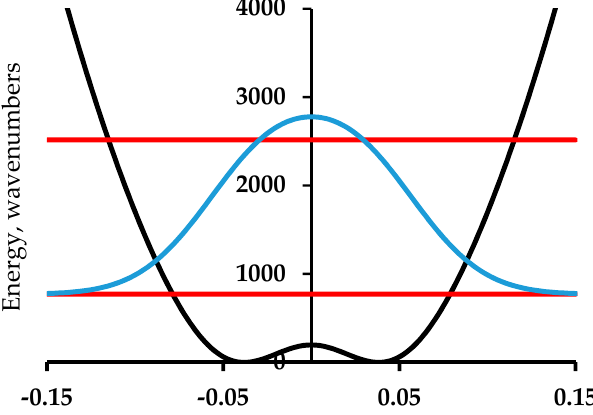
Displacement from symmetry point, Å Figure 5. An analytical model potential energy (black curve) for the Peierls bond alternation mode of polyacetylene. The function is a harmonic oscillator plus a Gaussian barrier [19]. The lines are as in Figure 4.